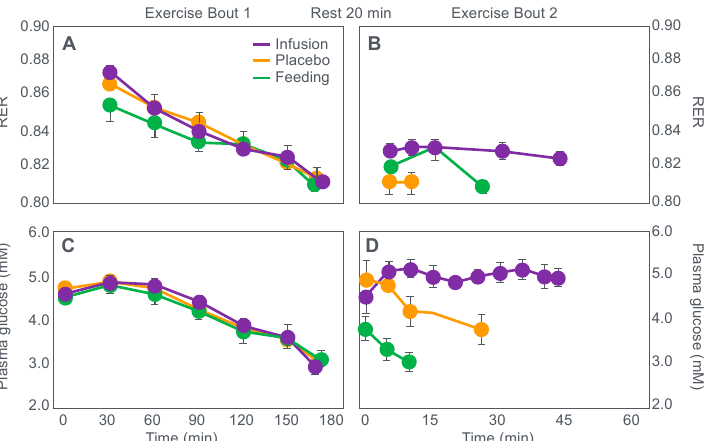
Figure 8. Changes in respiratory exchange ratio (RER) (panel A ) and in plasma glucose concentrations (panel C ) in athletes during an initial bout of 180 min of exercise (Exercise Bout 1) that induced profound hypoglycemia in all the athletes. (Panels B , D ) show changes in these variables in three groups of athletes who received either a placebo or carbohydrate by mouth, or a continuous glucose infusion during Exercise Bout 2 that followed 20 min after the conclusion of Exercise Bout 1. Adapted with permission from ref. [27]. Copy-right 1987 American Physiological Society.